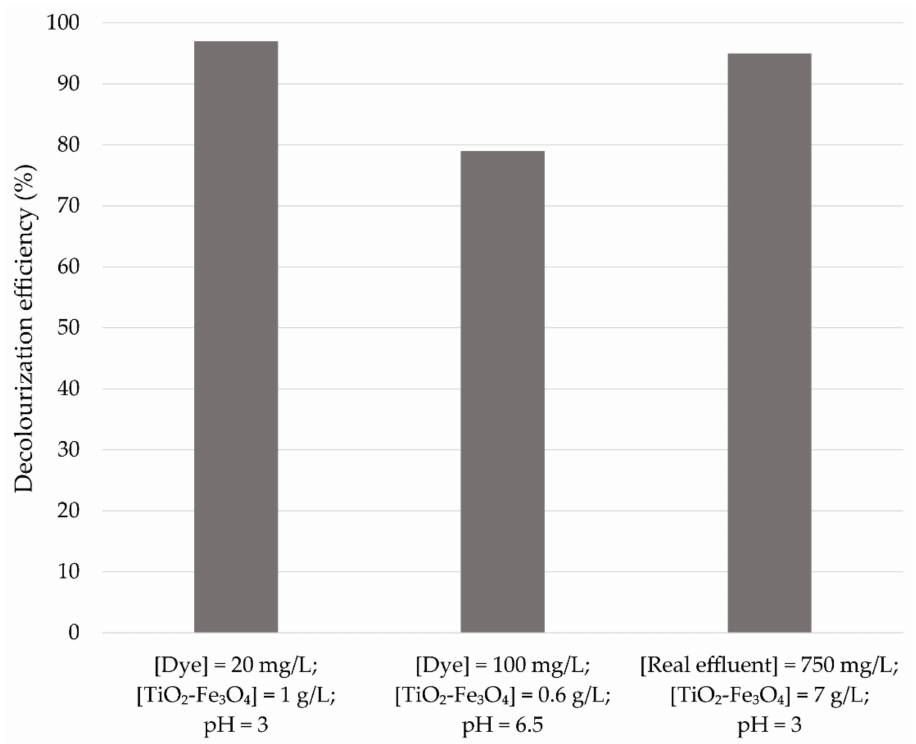
Figure 8. Decolourisation efficiency verification for synthetic dye solution (maximal efficiency and optimal conditions) and real effluent (maximal efficiency